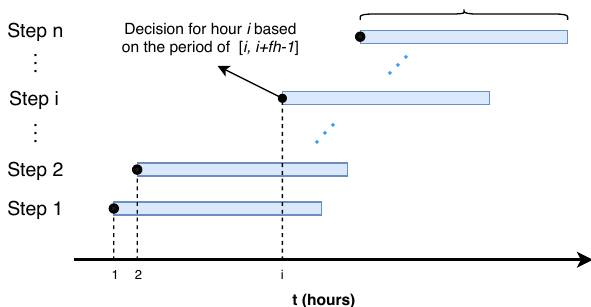
Figure 4. Modeling close to real-time with a short foresight rolling